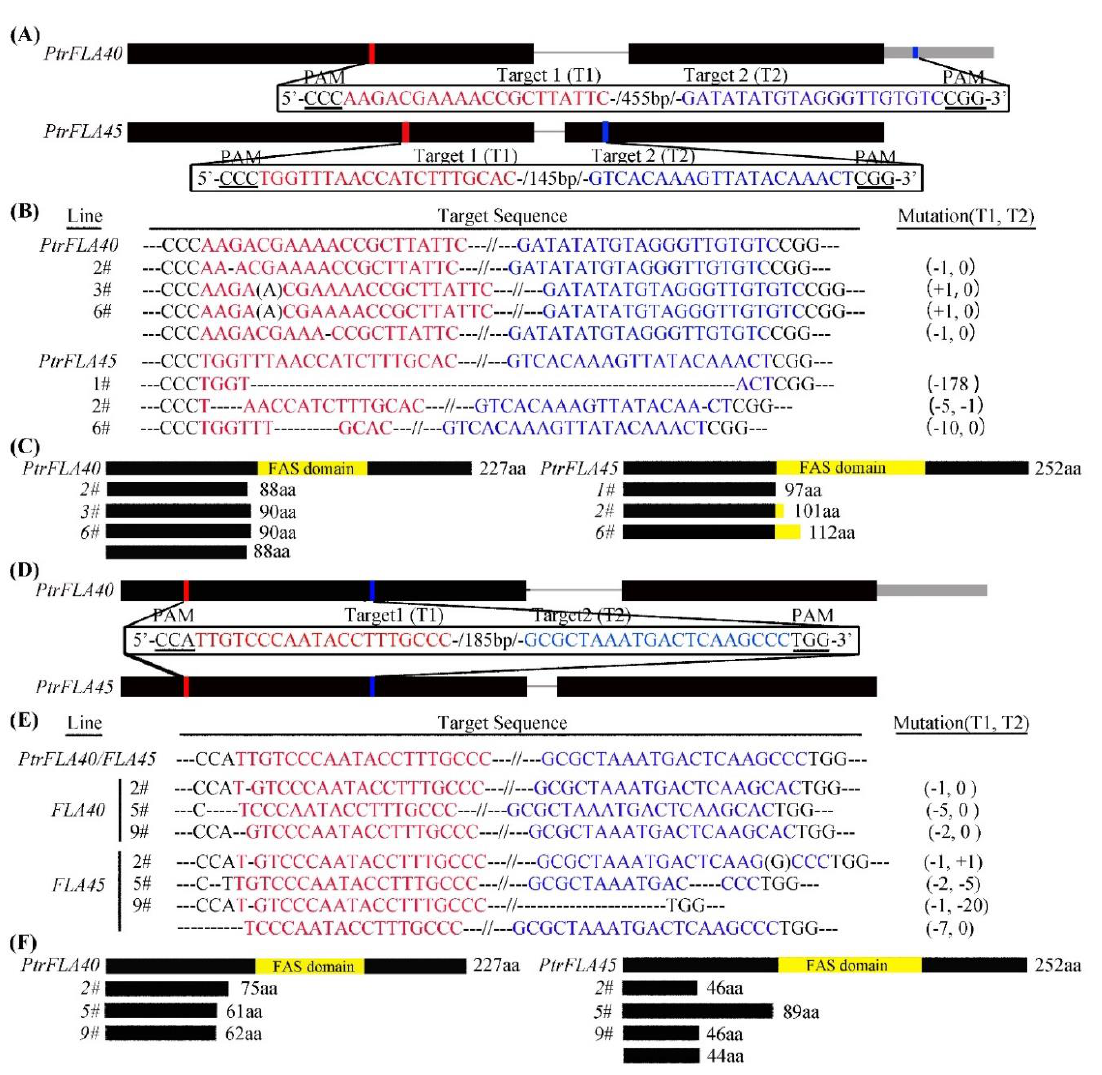
Figure 3. Cas9/gRNA-mediated mutations in the PtrFLA40 , PtrFLA45, and PtrFLA40/45 genes. ( A , D ) Two different target sites in red or blue were selected for editing PtrFLA40 , PtrFLA45 , or PtrFLA40/45 , respectively. Black and gray boxes represent the exons and 3′ UTR of the gene, respectively. ( B , E ) The mutations in PtrFLA40 , PtrFLA45 , or PtrFLA40/45 in the mutants ( ptrfla40-2#, -3# and -6# , ptrfla45-1#, -2#, and -6# , ptrfla40fla45-2#, -5#, and -9# ). Black letters in parentheses and dashes represent the insertion and deletion nucleotides, and the number is indicated at the right side of each panel. ( C , F ) Deduced amino acids of protein-coding regions from the Cas9/gRNA-edited genes in ptrfla40 , ptrfla45, and ptrfla40fla45 mutants. The amino acid number of the mutated proteins is indicated at the right. The yellow boxes represent the FAS domain.